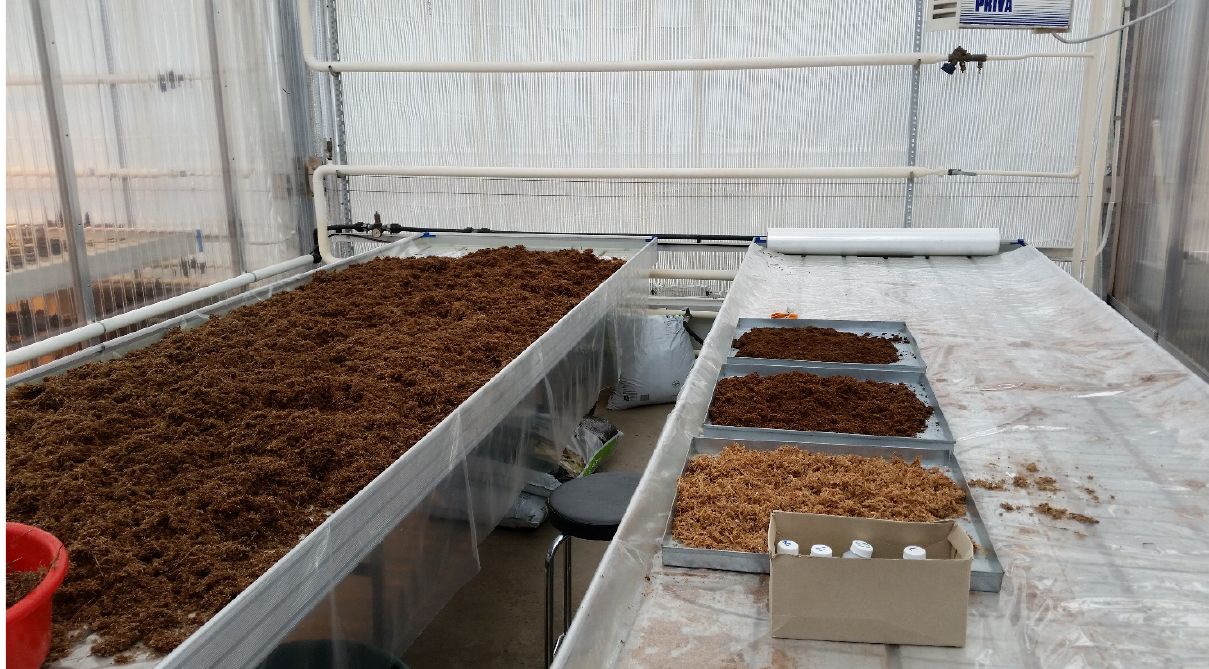
Figure 1. Left: the machine-harvested Sphagnum biomass appeared short-cut and processed without further treatment. Right: samples of the three experimental materials on metal trays - light peat (top), machine- harvested Sphagnum biomass (middle), and S. fuscum dominated biomass